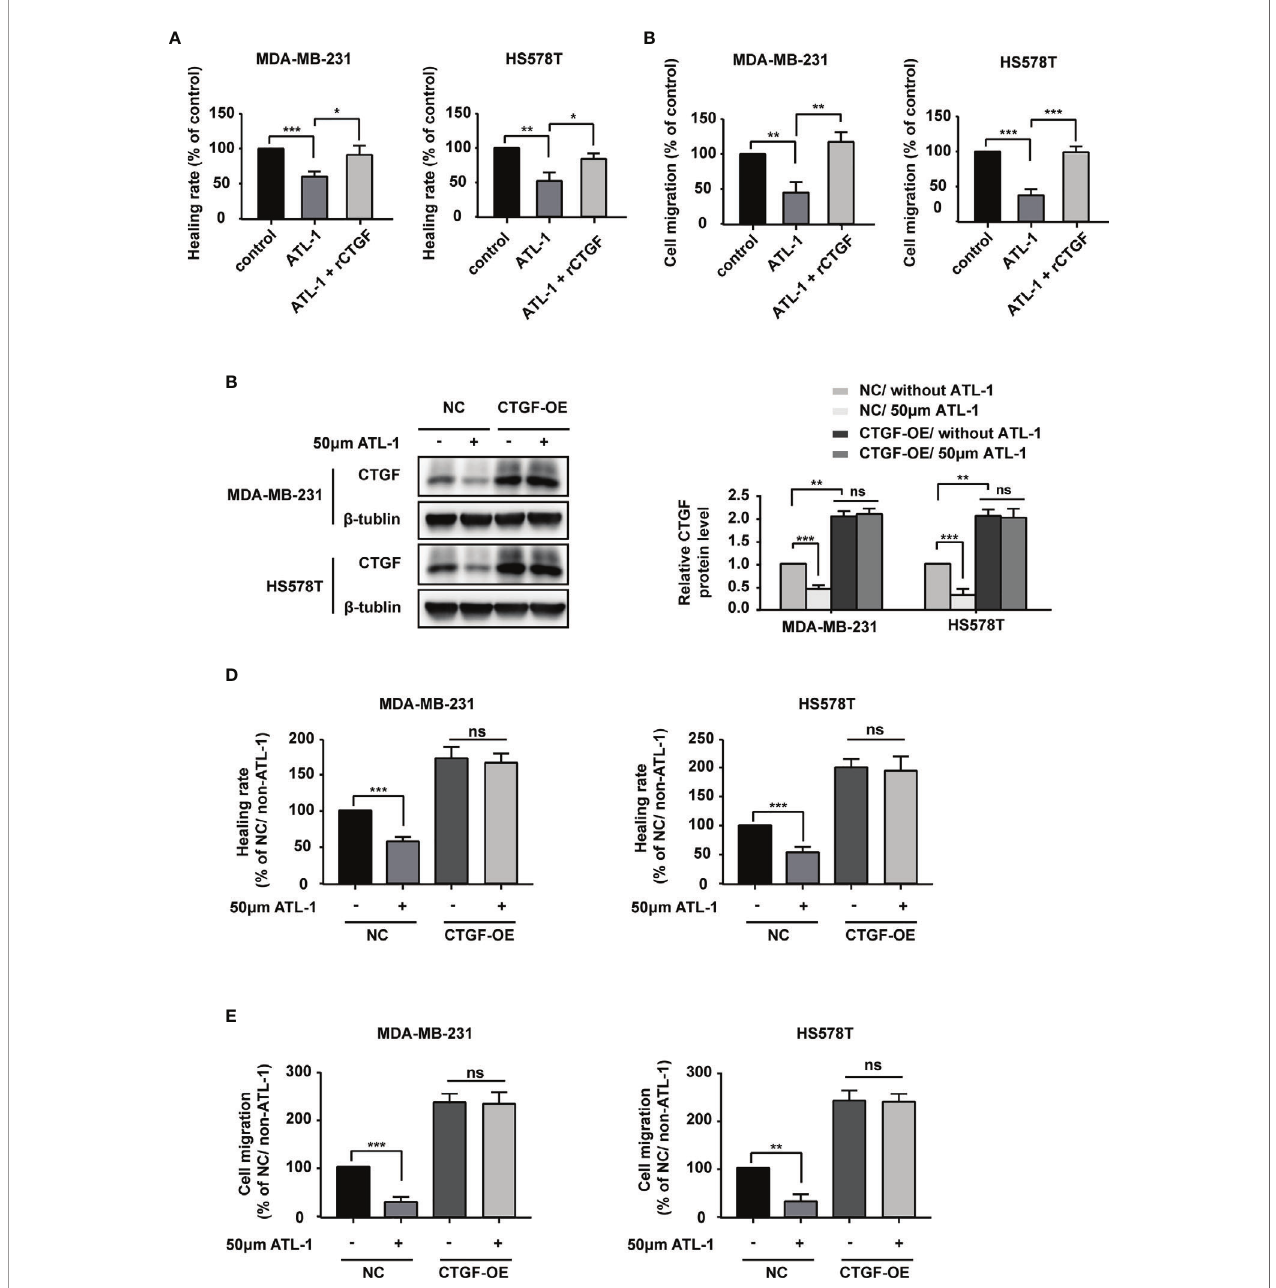
FIGURE 3 | ATL-1 inhibits triple-negative breast cancer cell migration via CTGF. Wound healing (A) and transwell migration (B) assays showed that the reductions in MDA-MB-231 and HS578T cell migration induced by ATL-1 were rescued by rCTGF. (C) Western blotting demonstrated that CTGF was overexpressed in MDA-MB-231 and HS578T cells by CTGF-OE lentivirus. After being overexpressed, there was no difference in CTGF expression between with and without ATL-1 treatment. Wound healing (D) and Transwell migration (E) assays showed that the reductions in MDA-MB-231 and HS578T cell migration induced by ATL-1 were attenuated in CTGF-OE cells. (A – E) Three technical replicates were performed for each of the three biological replicates. Mean ± SD, *p < 0.05, **p < 0.01, ***p < 0.001 by Student ’ s t